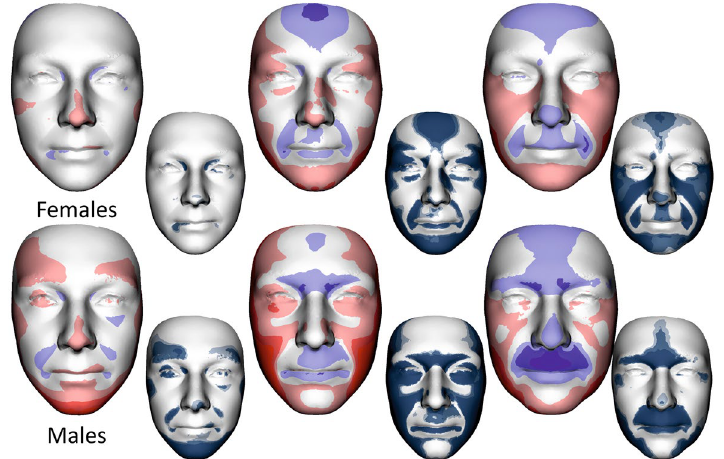
Figure 4. Colour-coded maps and shell distance significance maps describing average facial form differences between 0 and I, I and II, II and III age categories in females (upper row) and males (lower row). The most protrusive parts of the average faces are represented in red, whereas those that are situated deeper are coloured blue. The statistical significance of form differences was analysed per vertex and coded in shades of blue (significant differences) or grey (no significant differences) on the superimposed average